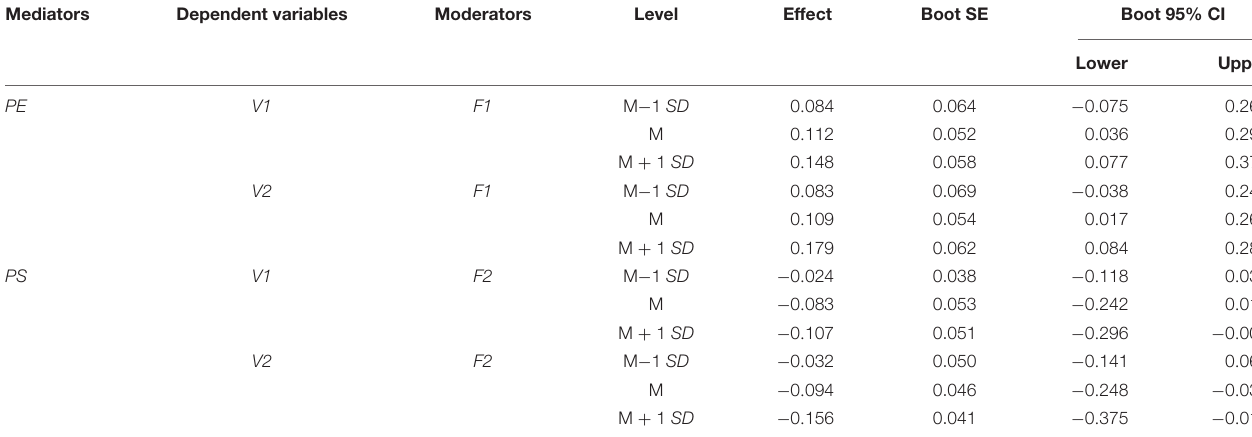
TABLE 5 | Results of moderated mediation